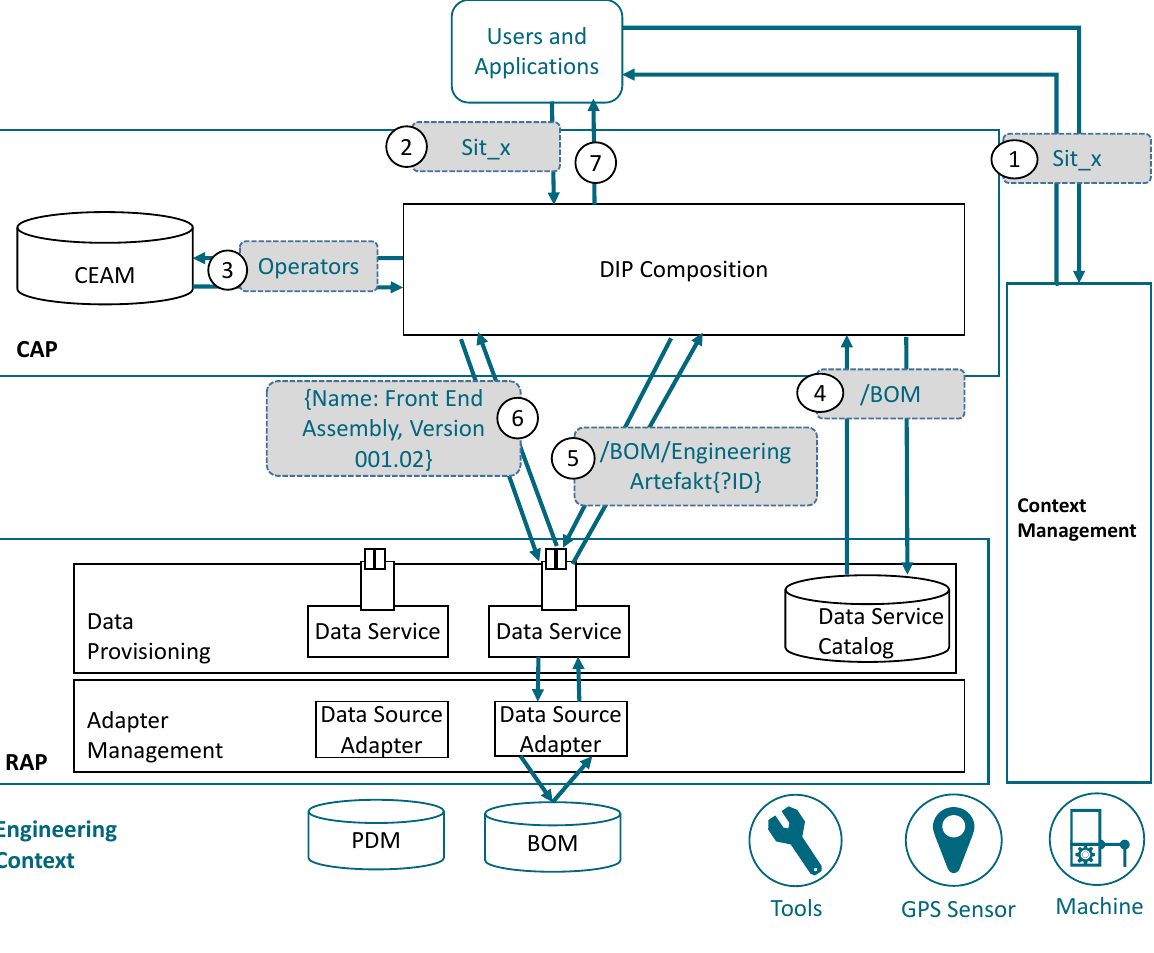
Figure 7. Example scenario to compose